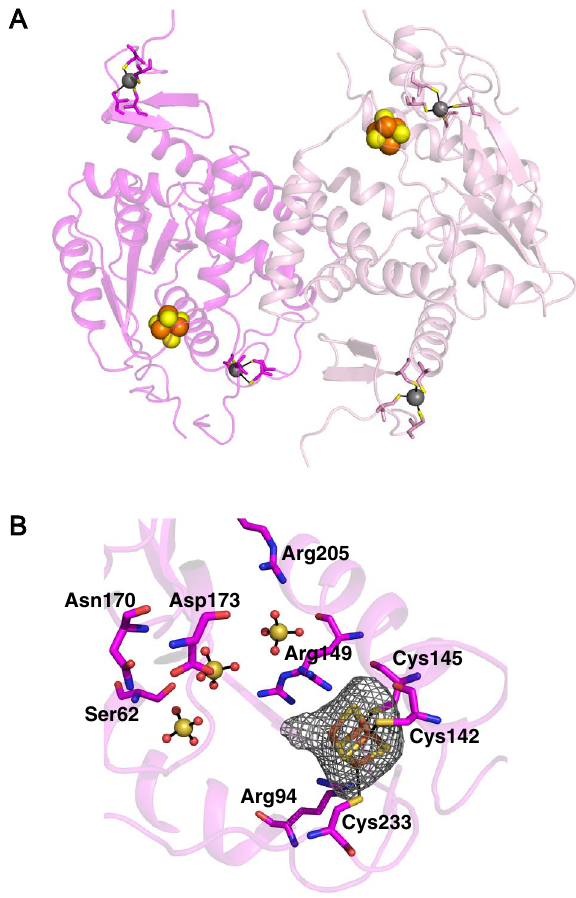
Figure 4. Crystal structure of holo-MmNcsA. ( A ) Overall view of the dimer. The cluster of MmNcsA is shown as orange (iron) and yellow spheres (sulfur). The zinc atoms are shown as grey spheres. MmNcsA-A is shown in pink; MmNcsA-B in magenta. ( B ) Zoom showing the [4Fe-4S] cluster in molecule A bound by 3 cysteines only, at the active site of holo-MmNcsA with a superposed Fo-Fc difference map omitting the [Fe-S] cluster contoured at 3 σ (in grey). Sulfate molecules near the cluster are depicted as